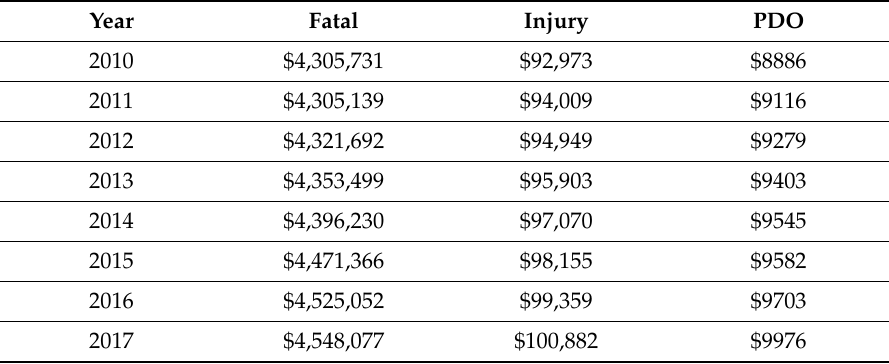
Table 4. Adjusted unit crash cost (USD) of three